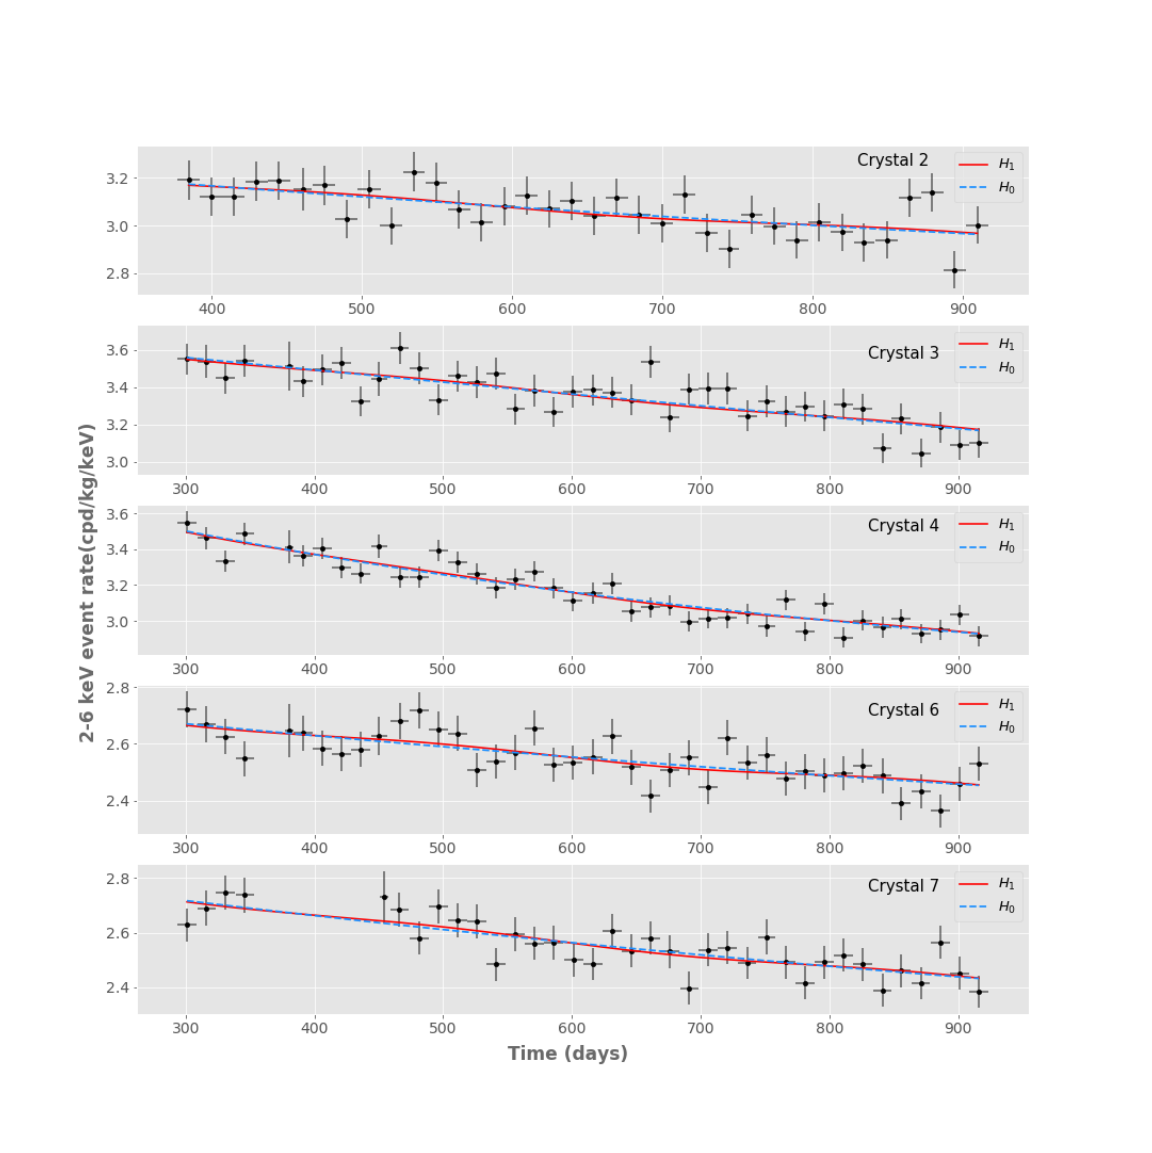
1 ( t ) (Eq. 1, in red) with period fixed at